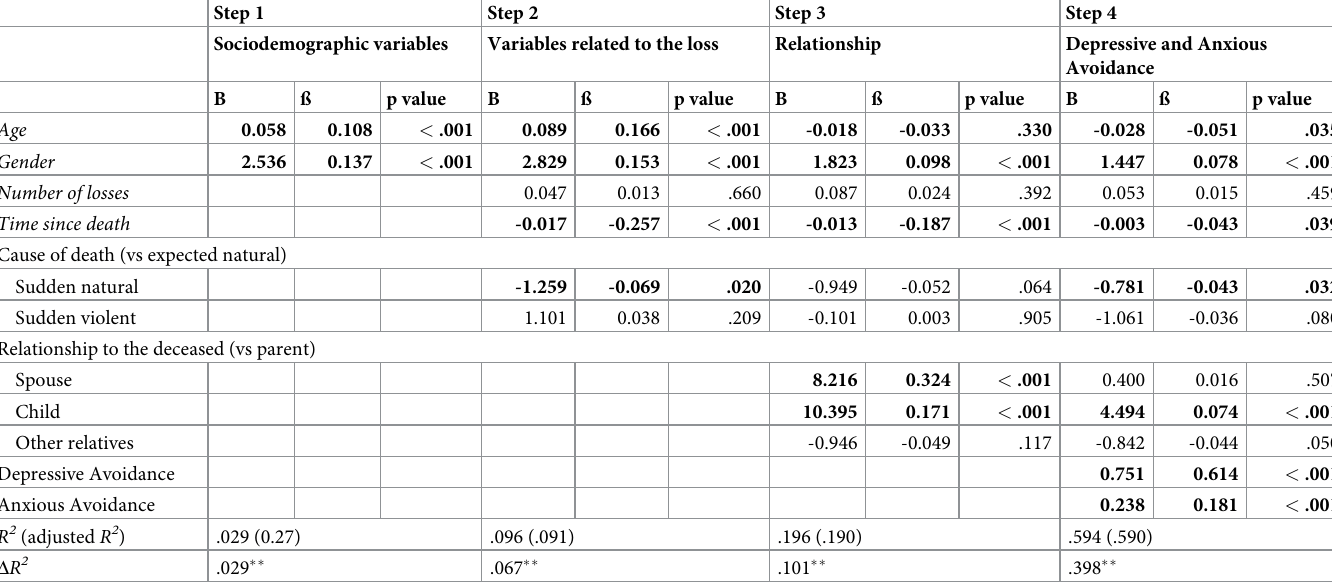
Table 6. Results of hierarchical regression for predictors of PGD symptoms (n =